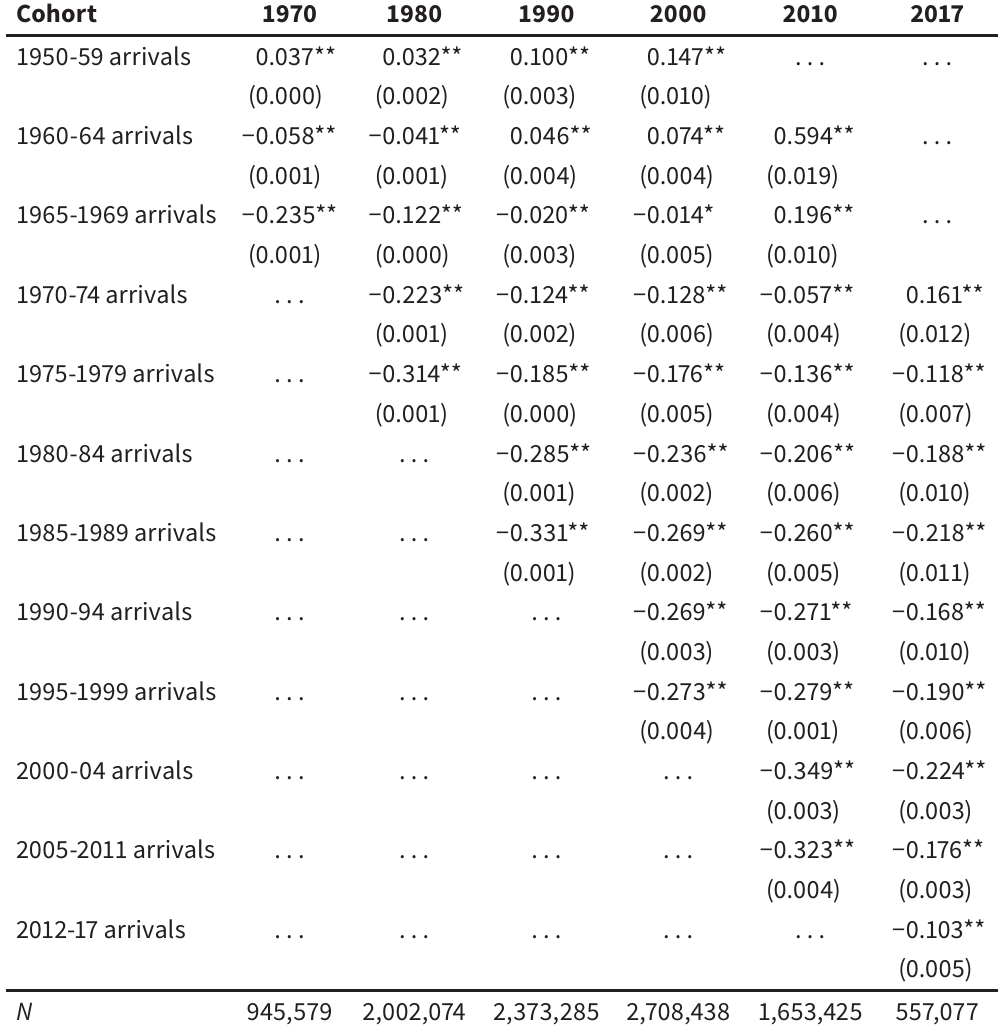
Age-adjusted relative log weekly earnings of immigrant cohorts from